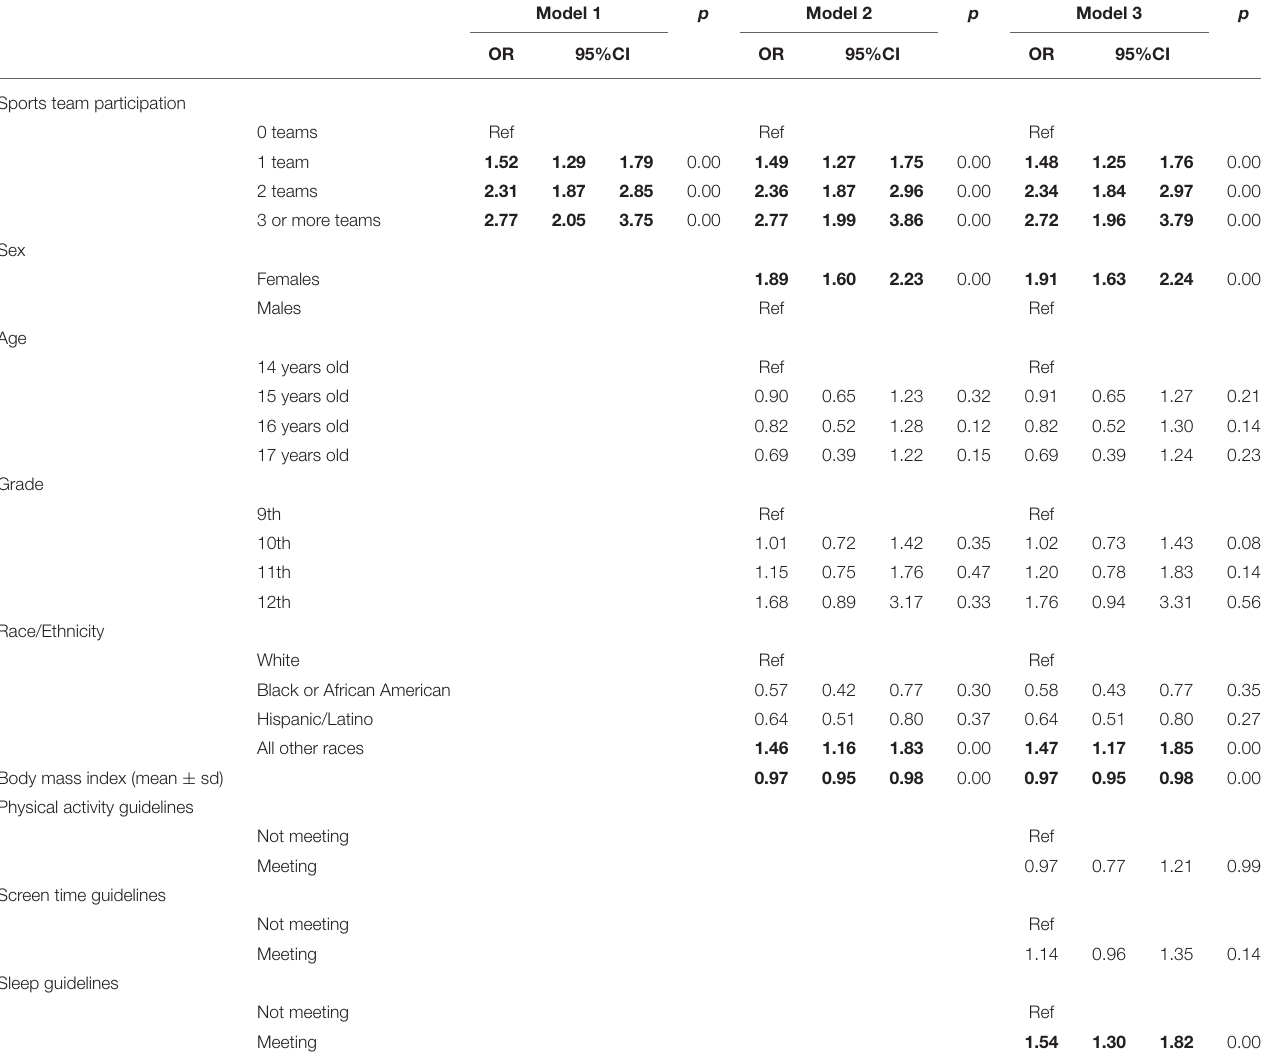
TABLE 2 | Parameter estimates obtained from the multiple logistic regression model weighted based on the outcome of academic performance (A’s and